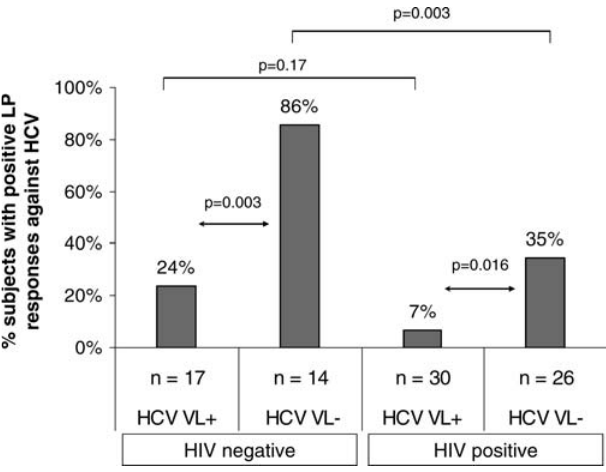
Figure 1. Rate of Detection of LP Responses against HCV Antigens by Subgroup, Stratified by HIV Status and HCV Viremia p -Values represent comparison of proportions per Fisher’s exact test. HIV (cid:1) persons with spontaneous control of viremia had the highest rate of detection (86%). By comparison, HIV þ persons with spontaneous control of viremia exhibited a 35% rate of LP responses. Both groups of controllers demonstrated significantly higher rates of detection than did their viremic counterparts. Fresh cells were not available for analysis of four of 30 HIV-1/HCV controllers.